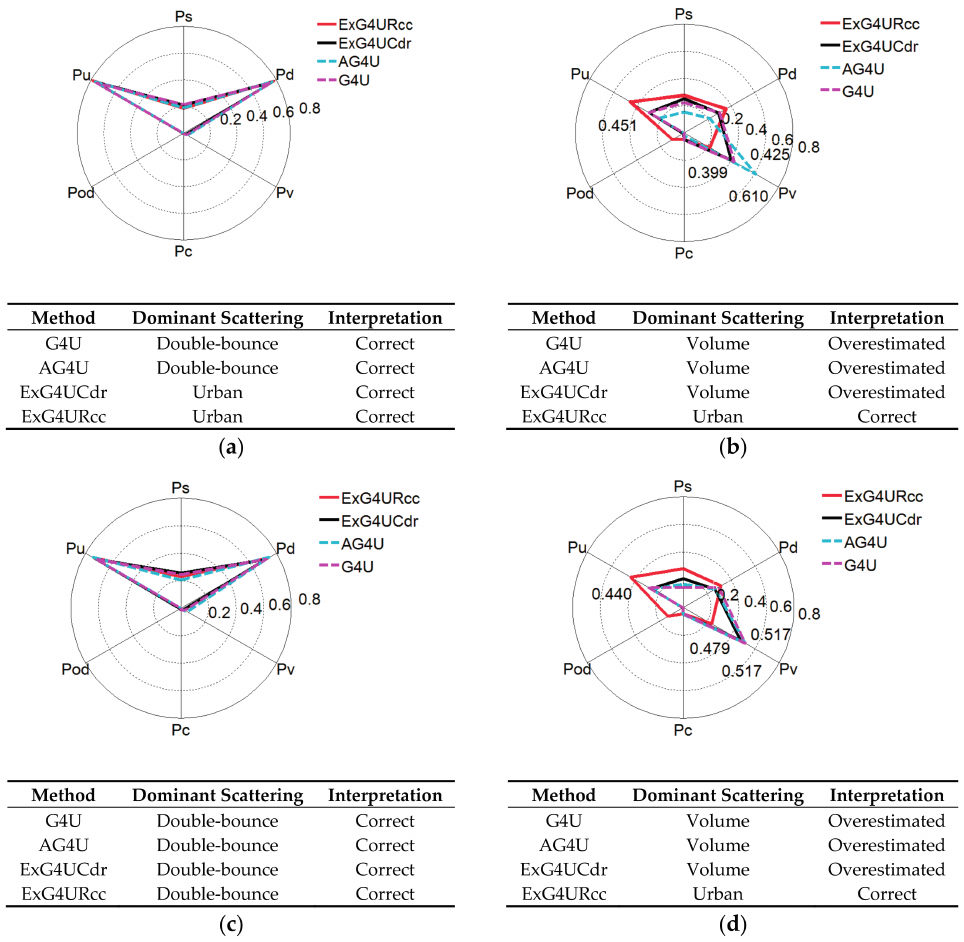
Figure 4. Color-coded scattering power decomposition with red (urban scattering), green (volume scattering), and blue (surface scattering): ( a – d ) decomposition results for C-band data using the conventional general four-component scattering power decomposition (G4U), the adaptive G4U (AG4U), the extended G4U (ExG4UCdr), and the hierarchical extended G4U (ExG4URcc) methods, respectively; and ( e – h ) decomposition results for L-band data using the G4U, AG4U, ExG4UCdr, and ExG4URcc methods, respectively.